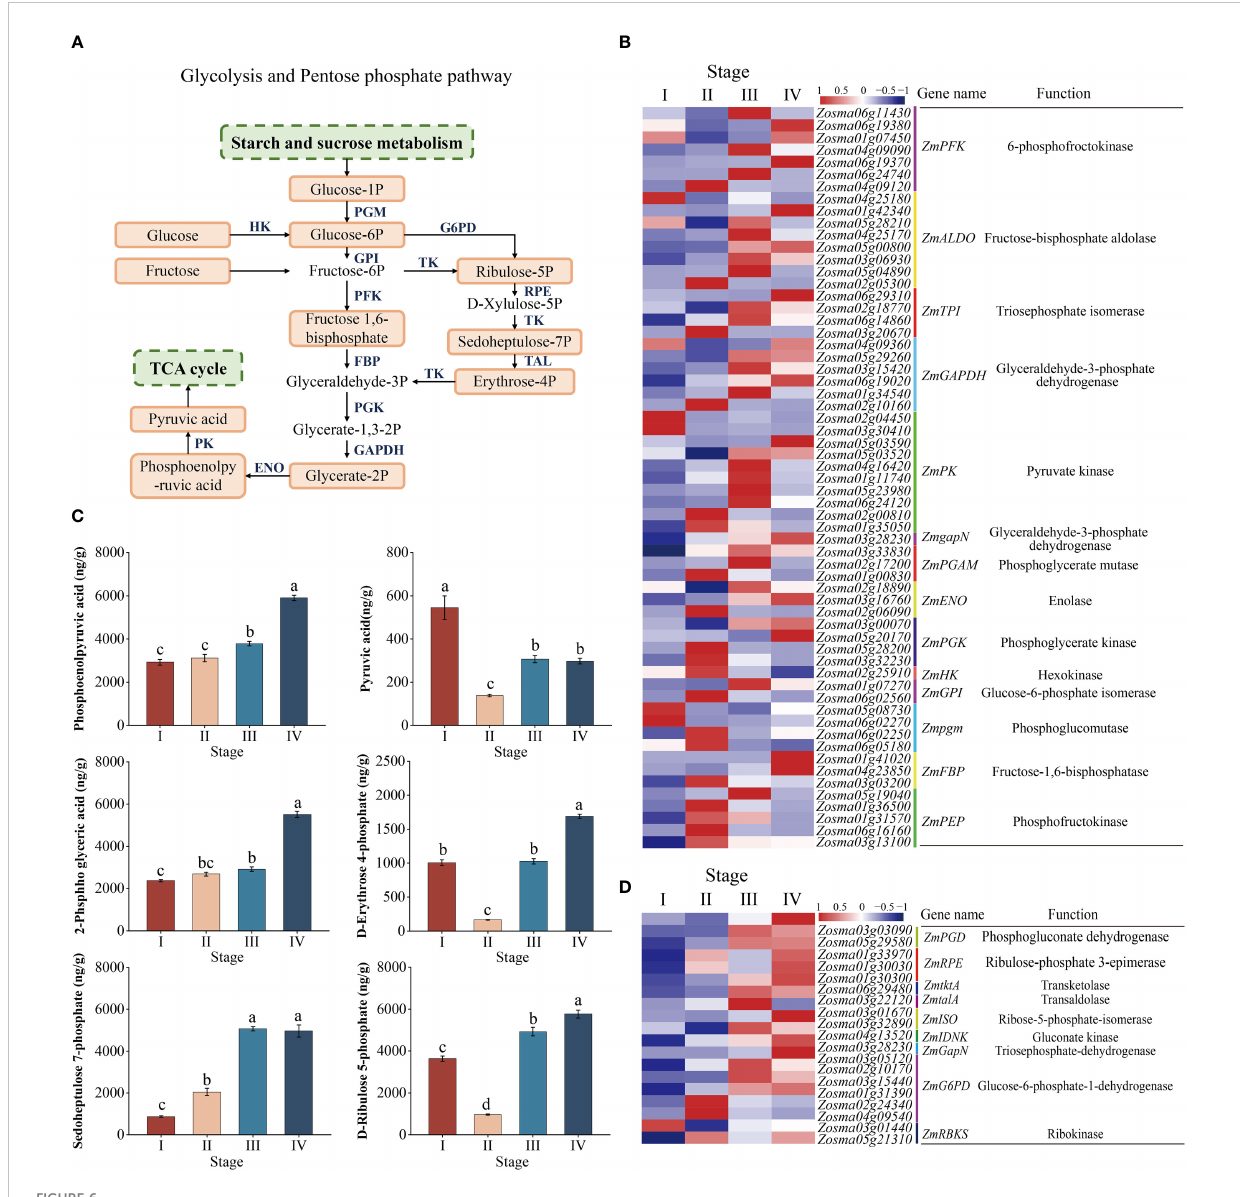
FIGURE 6 Glycolysis pathway and pentose phosphate pathway. (A) Model and key components of the glycolysis pathway and the pentose phosphate pathway in Zostera marina seeds. The highlighted boxes indicate the metabolites quanti fi ed from the LC – MS/MS results. (B) Heatmap analysis of DEGs (log 10 (FPKM) values) involved in the glycolysis pathway. (C) Analysis of changes in the metabolites represented in the glycolysis and pentose phosphate pathways during Zostera marina seed development. (D) Heatmap analysis of DEGs involved in the pentose and phosphate